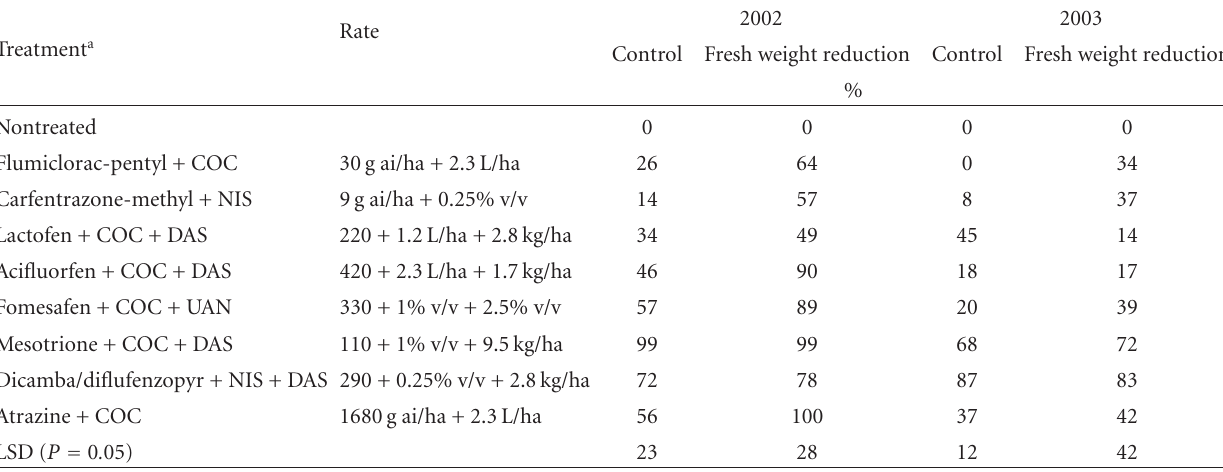
Table 3: Visual control and fresh weight reduction of common waterhemp population resistant to protox-inhibiting herbicides. Data were collected 21 days after